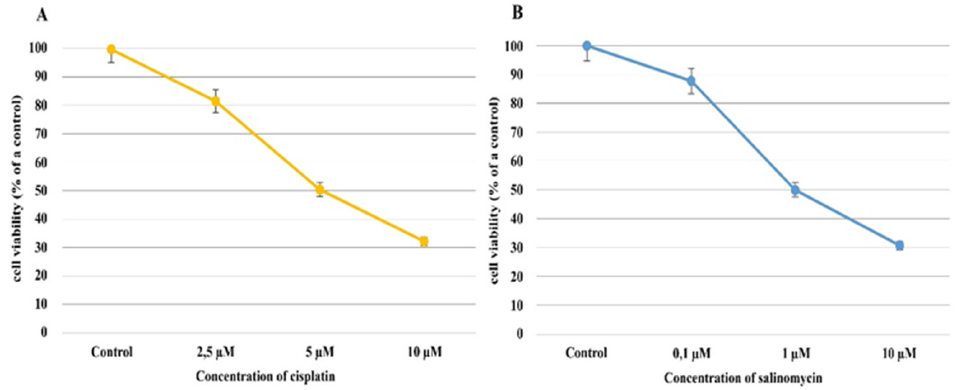
Figure 1. The results of the cytotoxicity assay of cisplatin ( A ) and salinomycin ( B ) on Ishikawa cell viability .